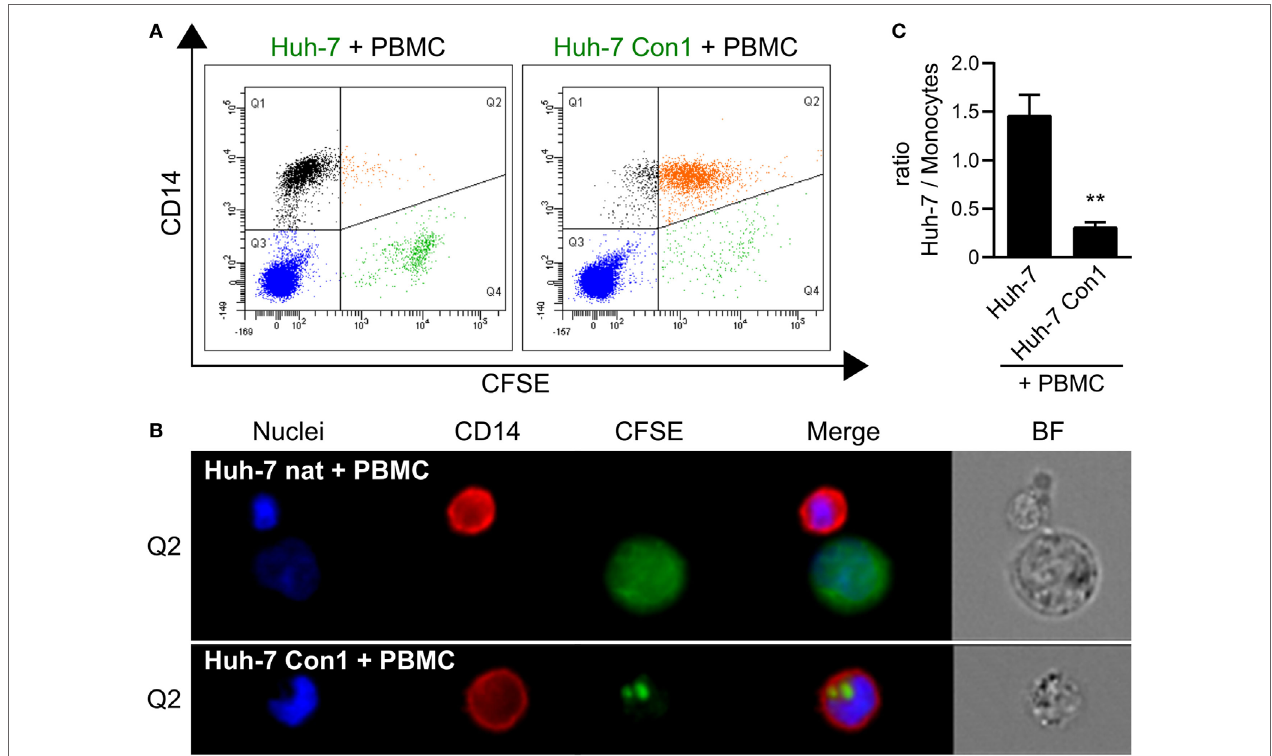
FigUre 2 | Phagocytosis of particles from hepatitis C virus subgenomic replicon cells by monocytes. Carboxyfluorescein succinimidyl ester (CFSE) stained Huh-7 cells were co-cultured with peripheral blood mononuclear cells (PBMCs). (a) Analysis of CFSE distribution in relation to monocytes (CD14 + ). (B) Uptake of Huh-7 cells by monocytes depicted by ImageStream analysis. (c) Ratio between Huh-7 cells and monocytes after co-culture based on flow cytometry analysis in (a) ( n =